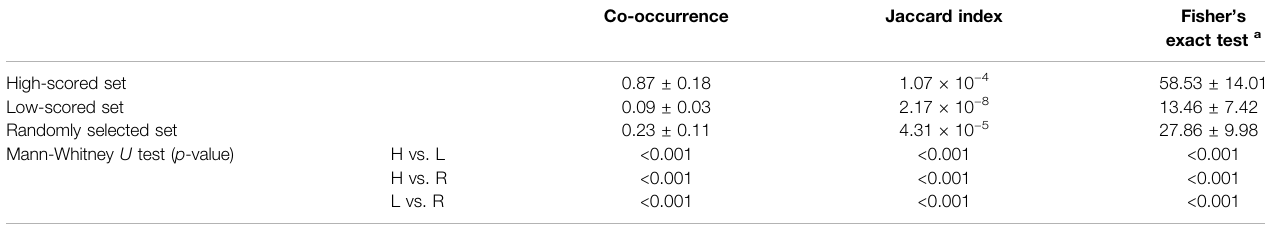
TABLE 4 | The statistical analysis was performed by comparing co-occurrence, Jaccard index and Fisher ’ s exact test values among high-score, low-scored, and randomly selected sets. Statistical signi fi cance was calculated by the p -value of Mann-Whitney U test.